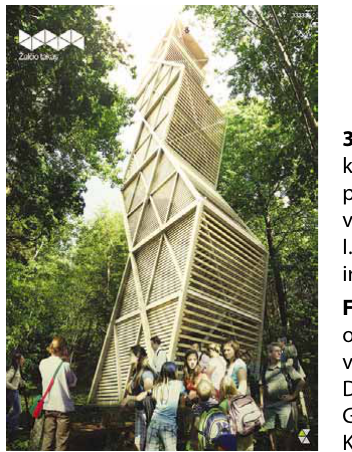
Fig. 32. Reconstruction of square de la